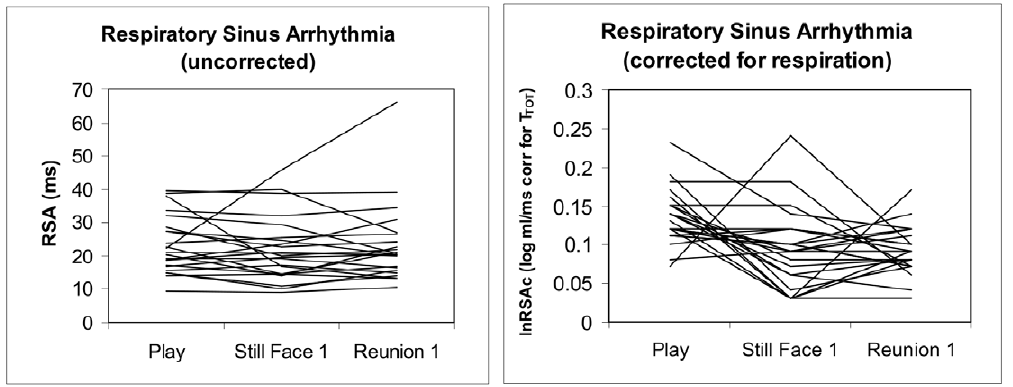
Figure 3. Individual trajectories of RSA uncorrected and corrected for respiration (both tidal volume and respiration rate) across the three episodes of the first Still-Face Test (n=23).